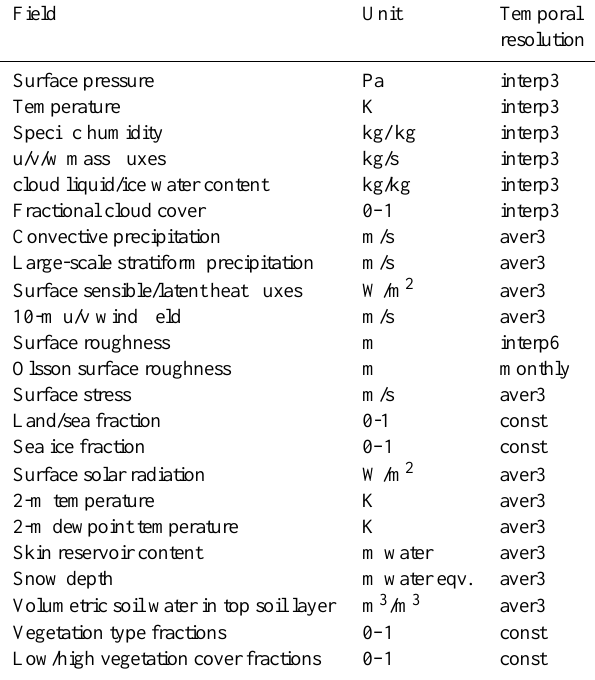
Table 1. Meteorological data from the ECMWF used in TM5. All surface related parameters are on a 1 ◦ × 1 ◦ horizontal resolution. Here “interp3/6” denote an hourly temporal interpolation between 3/6 hourly fields, “aver3” denotes 3-hourly time averaged fields and “const” denotes invariant fields during a